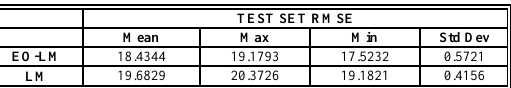
Fig. 5. The performance comparison of EO-LM and LM for BOF end-point temperature prediction Table 3. Comparison between the EO-LM and LM on BOF end-point temperature